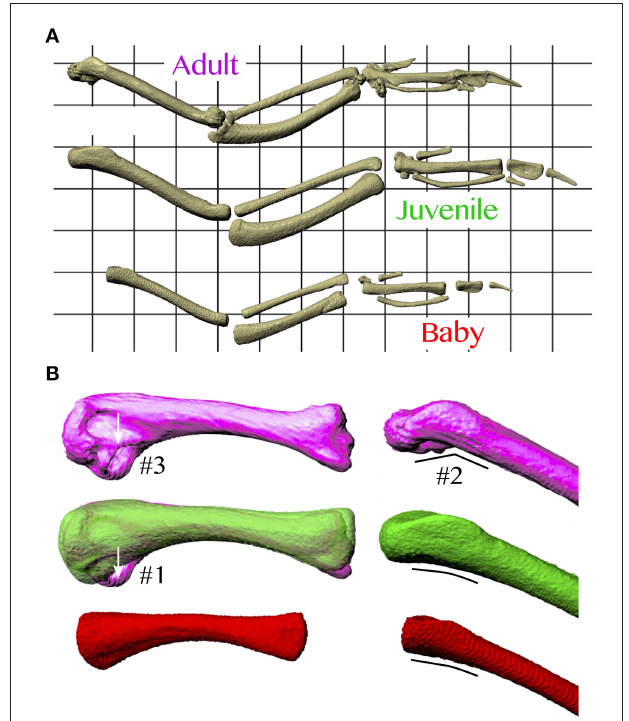
FIGURE 11 | Skeletal anatomy. (A) Images of right forelimbs in dorsal view, standardized by notarium length. The proportionally long moment arms and muscle-tendon lengths ( Figure 9 ) of the juvenile are likely due, at least partially, to its proportionally long and sometimes wide limb bones. (B) Images of right humeri (adult, purple; juvenile, green; baby, red), standardized by notarium length; left images in posterior view, right images in dorsal view. The proportionally long moment arms of the adult for long axis rotation at the shoulder ( Figure 9 ) are at least partially due to its expanded bicipital crest (#1), exaggerated angle between the head and shaft of the humerus (#2), and expanded margo caudalis